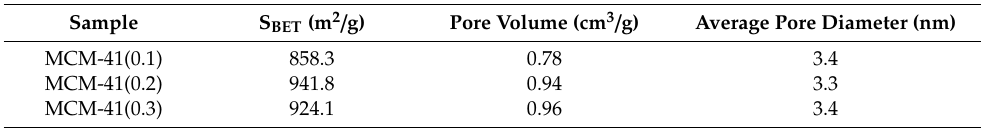
Table 3. Specific surface area and pore structure of diatomite and MCM-41 with di ff erent ratio of